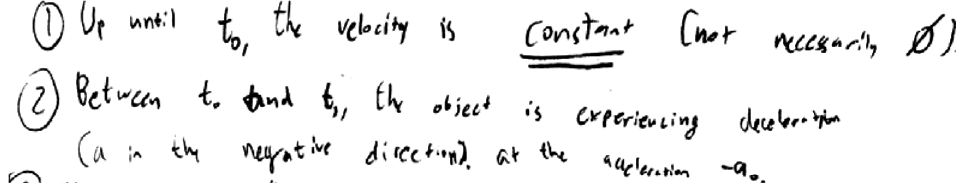
FIG. 6. Example of qualitative solution when interpreting the acceleration-time graph.